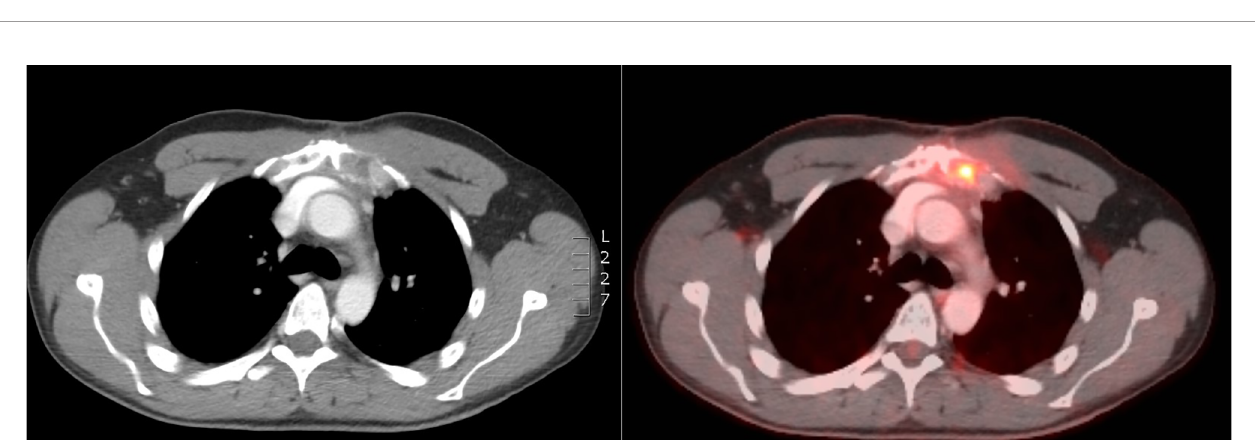
FIGURE 3 | CT scan at 2 months after RT showing volume increase of the sternal lesion, probably due to pseudo-progression.